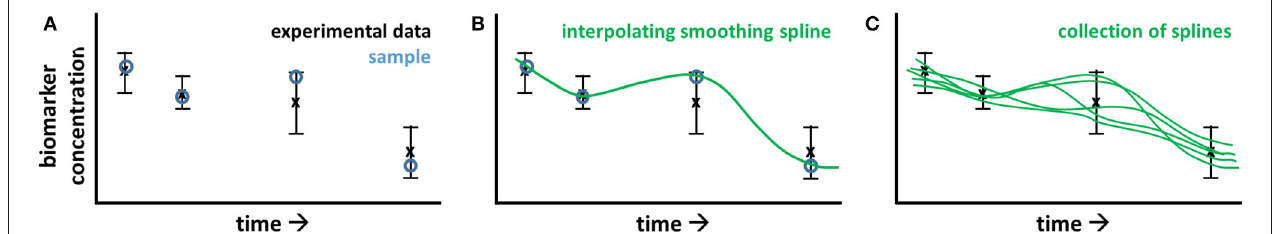
FIGURE 9 | Pre-processing of experimental data for ADAPT. The experimental data consists of time course, longitudinal data obtained at multiple, discrete points in time, describing the transition of the biological system. In (A) , the black error bars represent mean and standard deviation of the data at each point in time. A time continuous description of the data is obtained by spline interpolation. To account for experimental and biological uncertainties, a Monte Carlo approach is used. The data is randomly sampled assuming a data error model based on Gaussian distributions with means and standard deviations according to the experimental data ( A ; blue circles). A cubic smoothing spline ( B ; green line) is fitted through these samples. This process is repeated, obtaining a collection of splines (C)